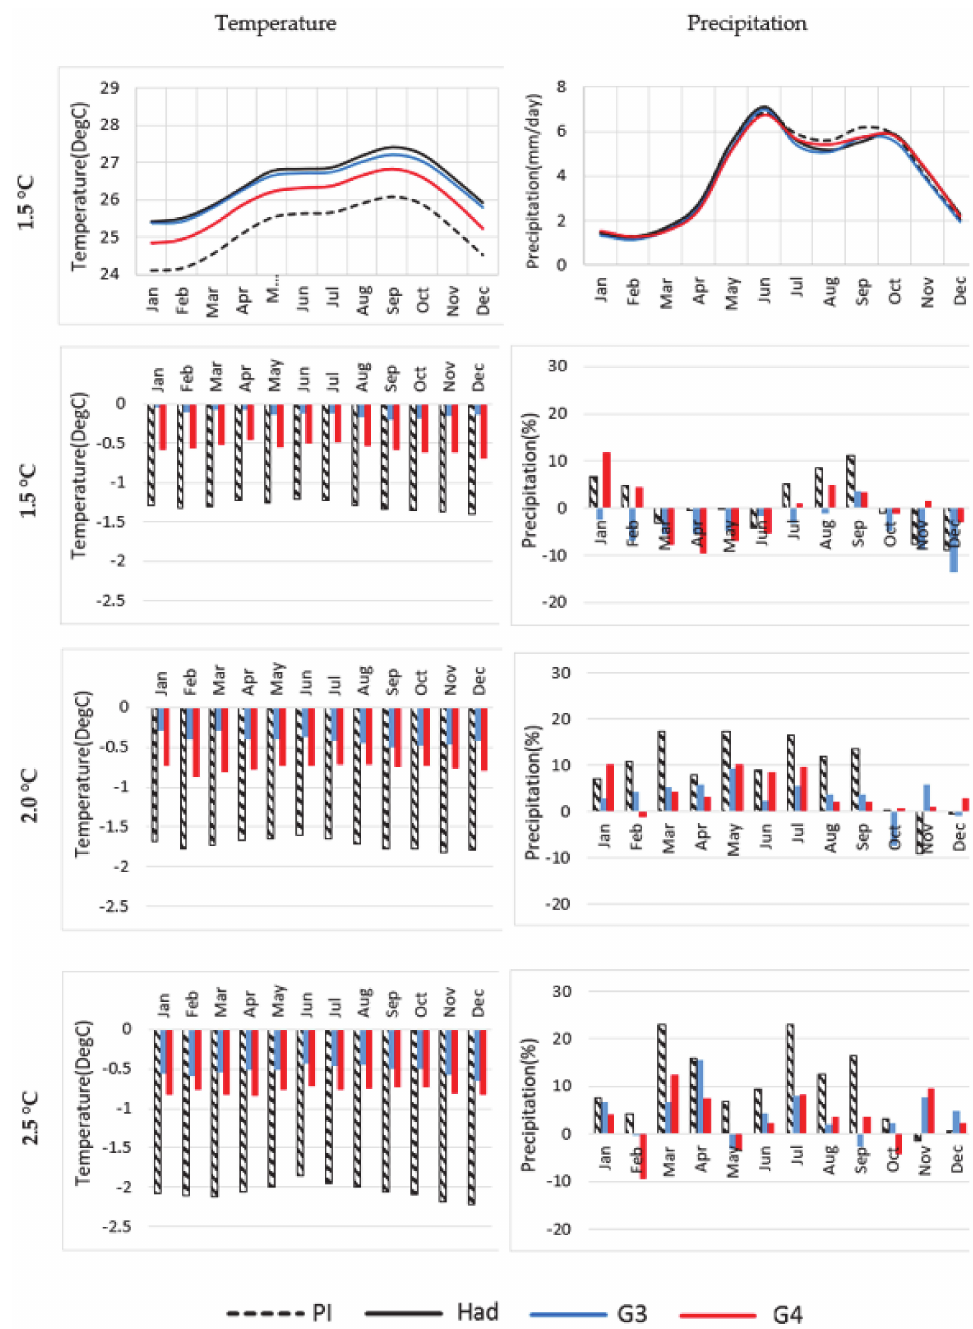
Figure 7. Row 1: Climatology plots of air temperature ( left panel) and precipitation ( right panel) for HadGEM_unaltered, G3 and G4 at 1.5 ◦ C, and for the preindustrial (PI) period (1860 to 1900). Rows 2 to 4: Difference plots between G3 (red), G4 (blue) and PI (hatched black) climatologies and the HadGEM_unaltered climatology at 1.5, 2.0 and 2.5 ◦ C. respectively. Row 1 shows actual values while rows 2 to 4 show absolute and percentage